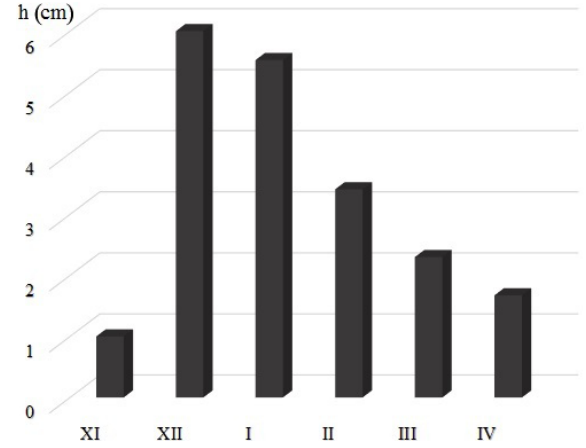
Figure 7. The maximum snow cover at the Ishkoshim meteorolog- ical station in the Pyanj river basin for the period 1944–2014.